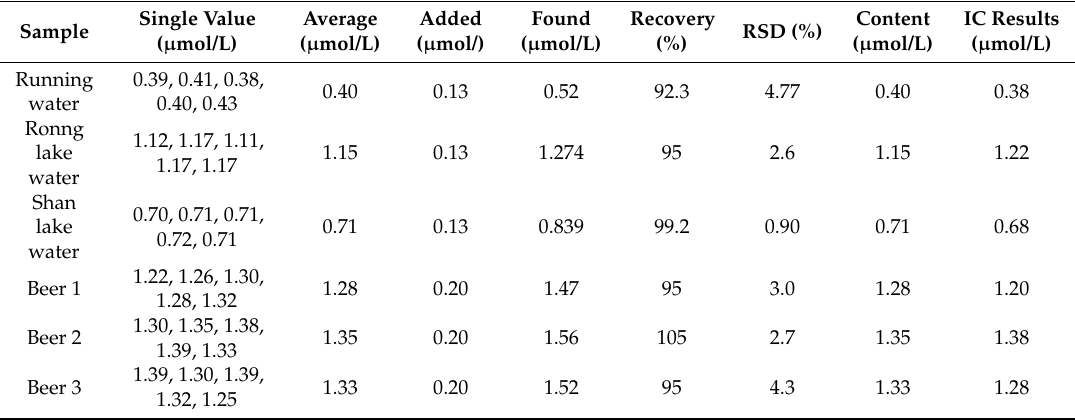
Table 4. Analytical results of sulfate in water